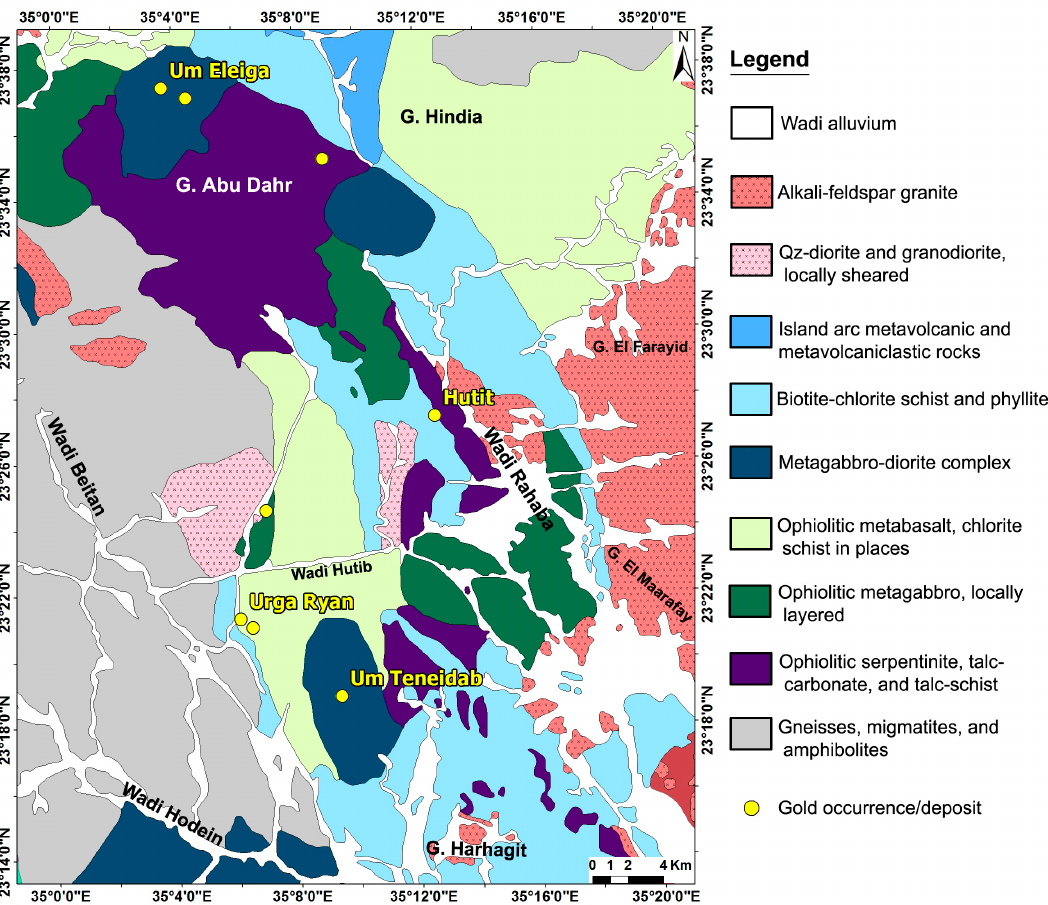
Figure 2. Geological map of Wadi Beitan–Wadi Rahaba area in South Eastern Desert (SED) of Egypt. Modified from Conoco Coral [37]. The unlabeled yellow filled circles are either insignificant or yet not studied occurrences.